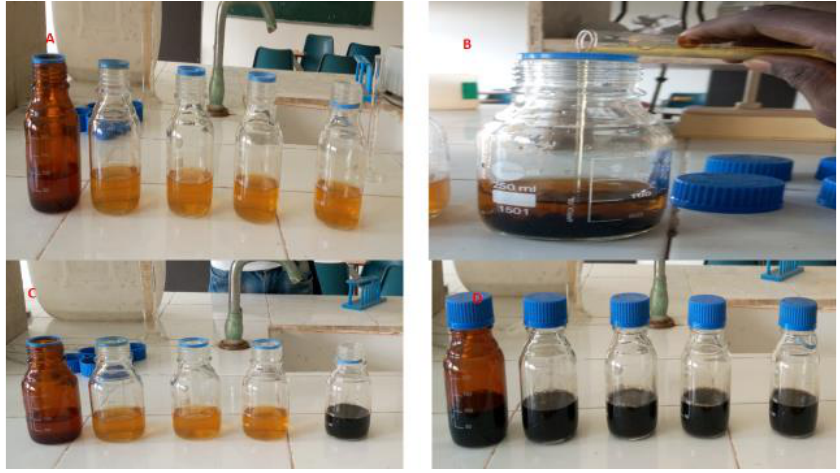
Figure 1: Depiction of the whole synthesis process Fig. 1. Depiction of the whole synthesis process.